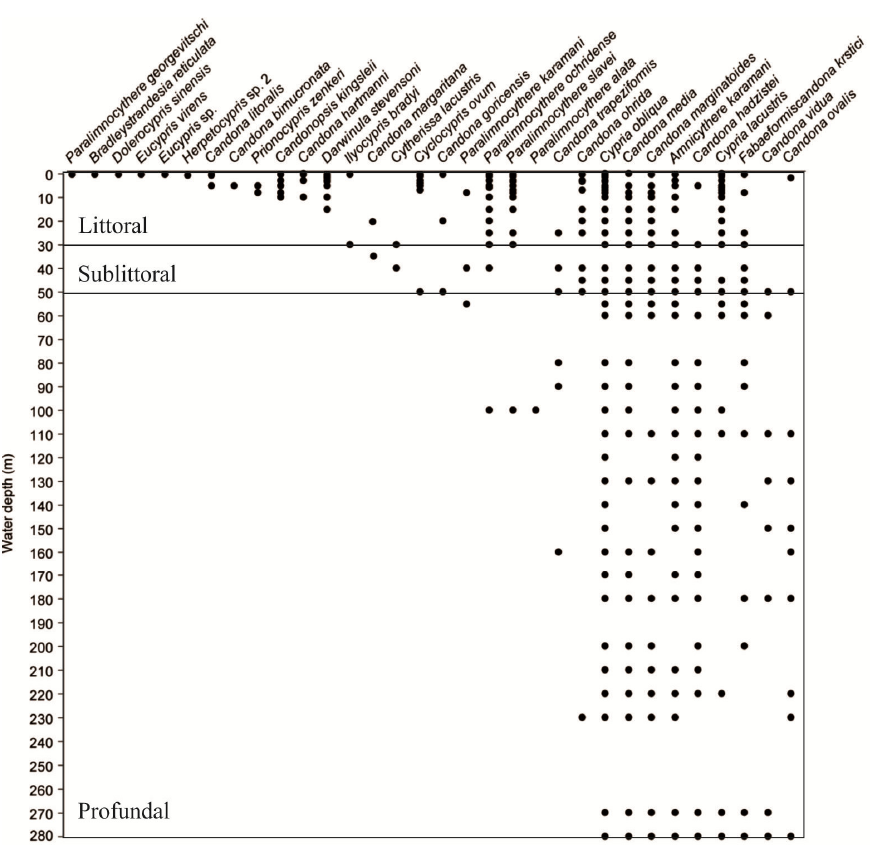
Figure 6. Depth distributions of living ostracodes in Lake